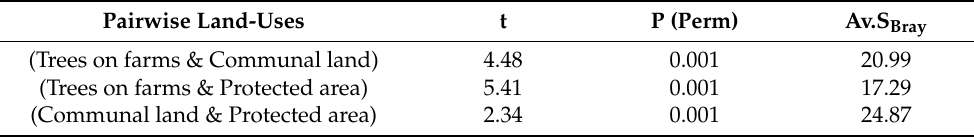
Table 3. PERMANOVA pairwise comparisons for species richness.